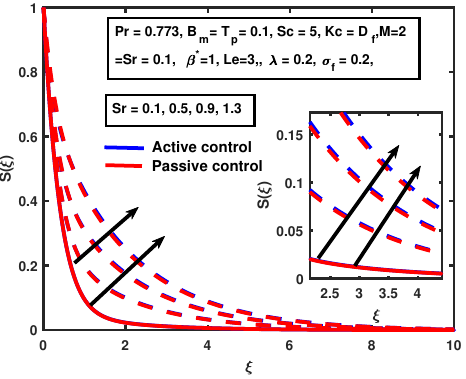
Figure 14. The impact of S ( ξ ) on Soret Sr